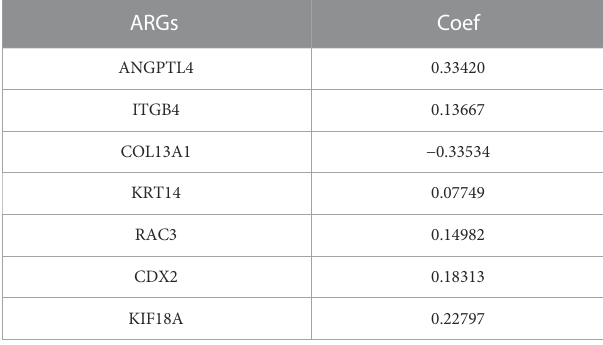
TABLE 1 Seven ARGs selected by multivariate cox results.